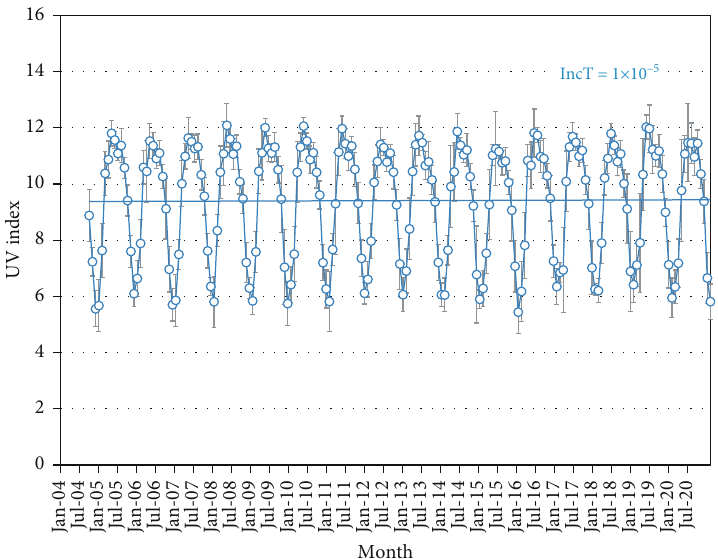
Figure 4: Time series variations in the monthly UVI (with standard deviation error bars) on the campus of KAU during the study